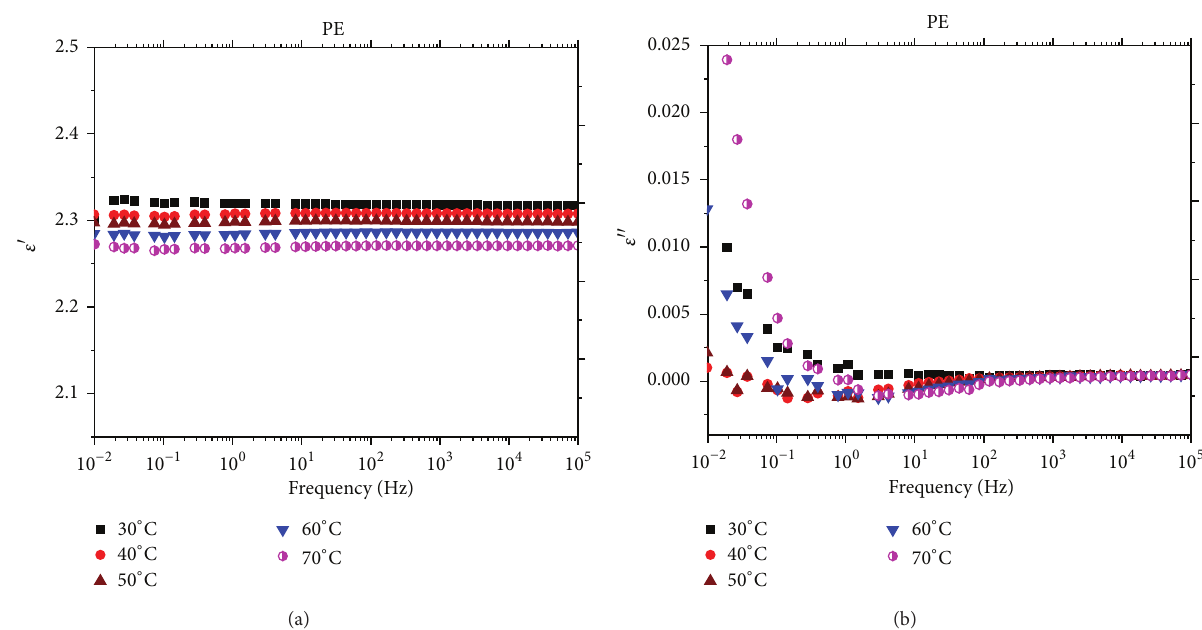
Figure 5: Relative permittivity 𝜀 󸀠 (a) and dielectric loss 𝜀 󸀠󸀠 (b) versus frequency at various temperatures observed for the neat PE blend.